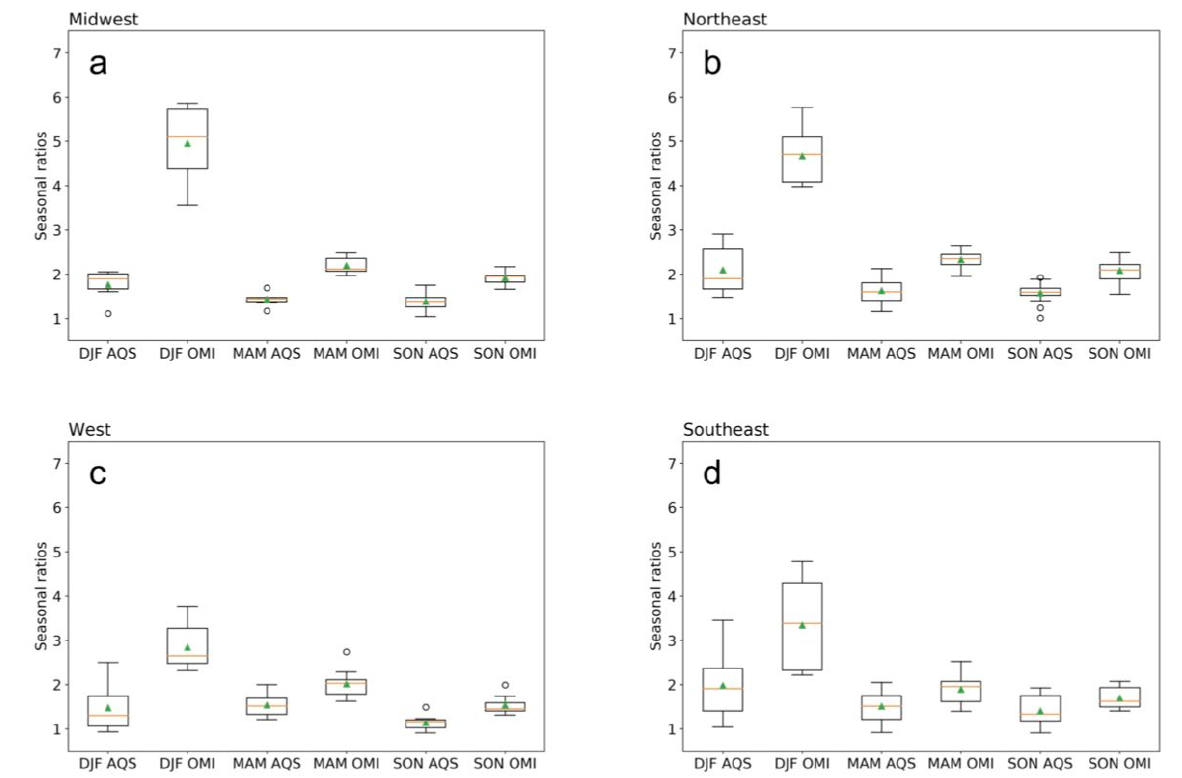
Figure 4. Summer to all other season ratios from AQS and OMI for the Midwest ( a ), northeast ( b ), west ( c ), and southeast ( d ). Red lines indicate regional median, green triangles indicate regional mean, and cycles represent extreme values.